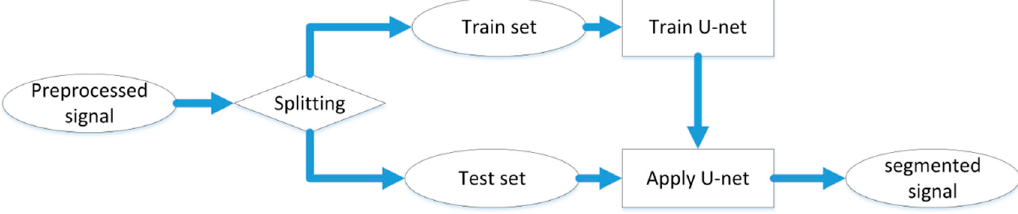
Figure 4. Diagram of the segmentation method: the division of training set and test set, model training.